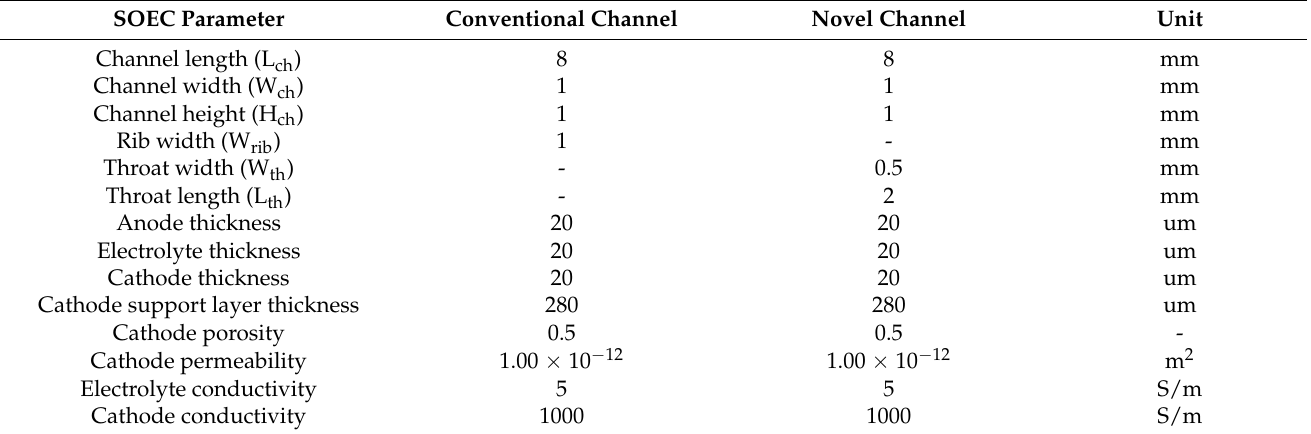
Table 1. Geometric and operating parameters for the SOEC with the conventional and the novel channel.